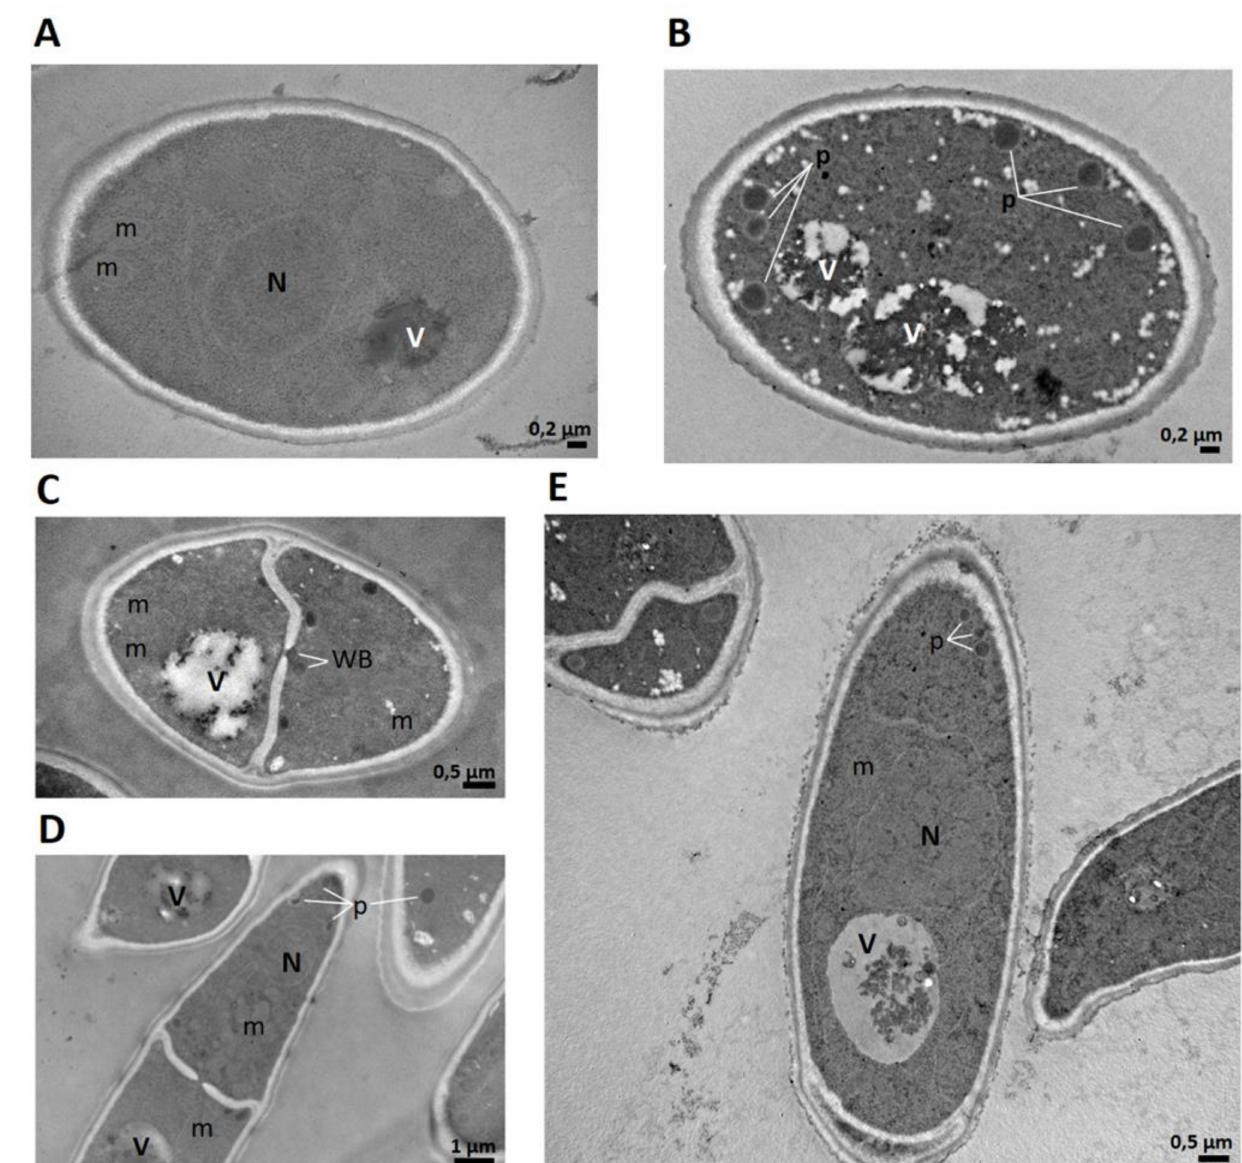
Figure 8. Transmission electron microscopy (TEM) images of Fusarium graminearum conidia incubated with peptide SmAP α 1-21 . ( A ) Untreated conidia cross-section, ( B , C ) cross-section; and ( D , E ) longitu- dinal section of treated conidia. In addition to morphological changes in the cell wall and cytoplasm, numerous electron-dense peroxisomes are observed near the cell membrane in treated cells, as well as Woronin bodies toward pore septa (p: peroxisomes; m: mitochondria; N: nucleus; V: vacuole, WB: Woronin body). Bar indicates size in µ